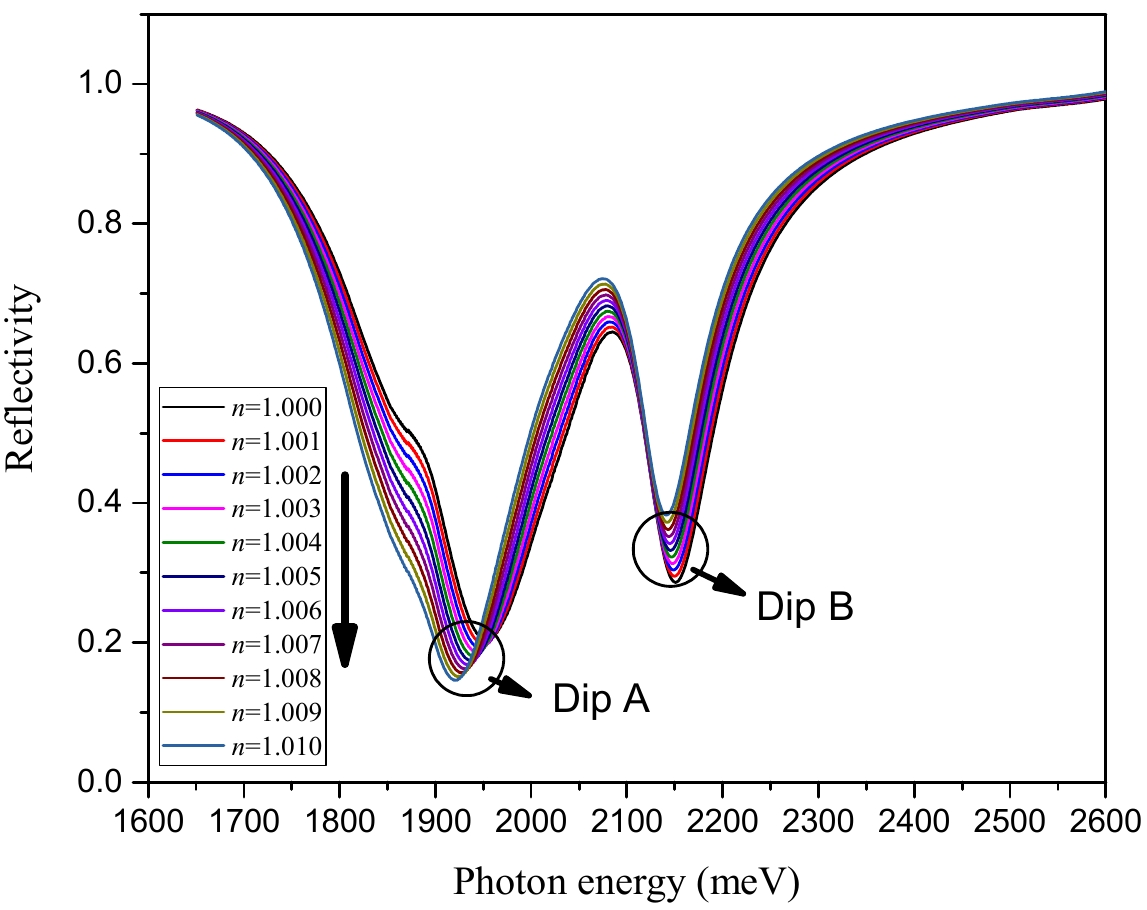
Figure 5. SPR reflection spectrum for a variable environmental refractive index with 43 nm Ag film, single-layer graphene, and three-layer MoS 2 .